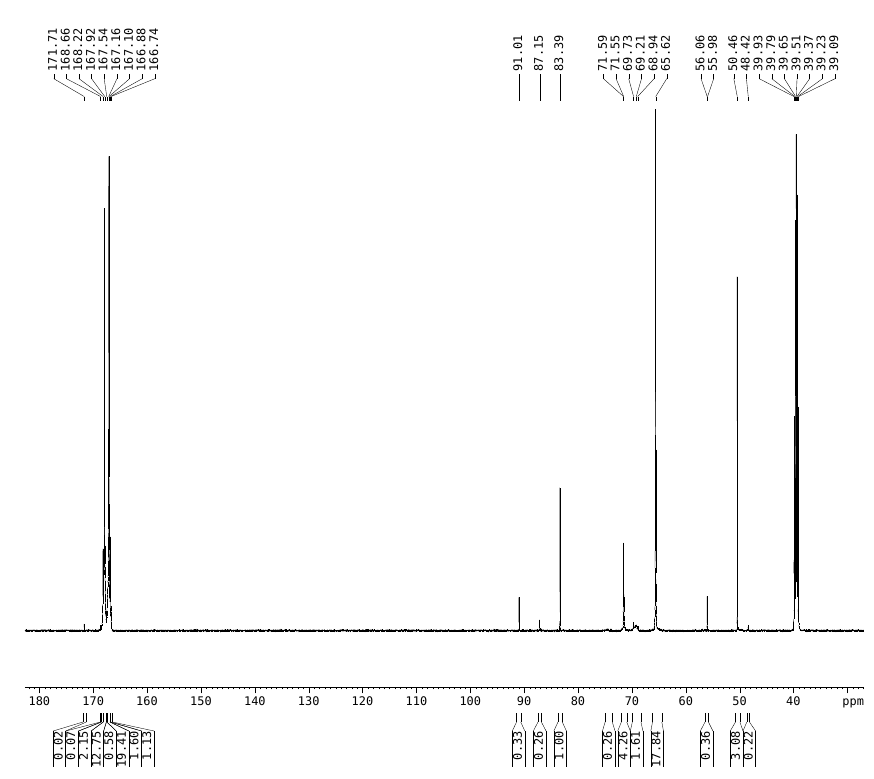
Figure 7. The 13 C NMR spectrum of sample